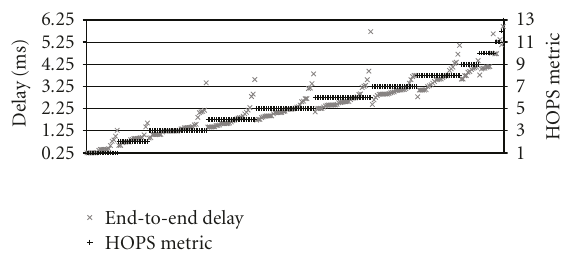
Figure 13: Comparison of HOPS metric and end-to-end delay variations ( f